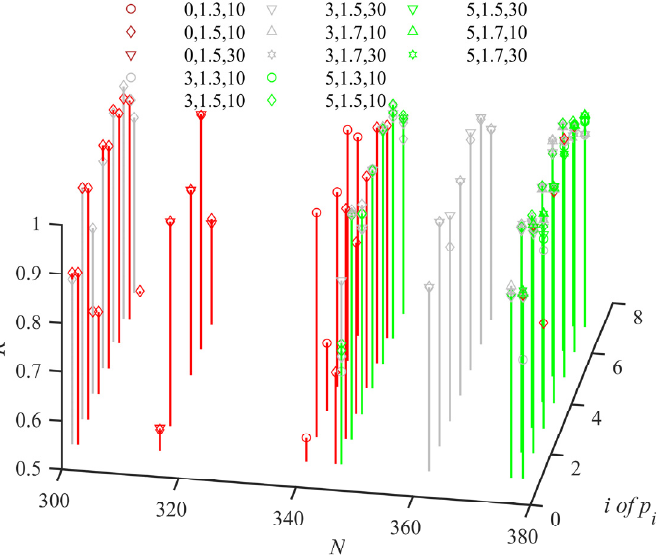
Figure 8. Surrogate models training with different sample points and combination of a p , P min and θ max . Table 2. Selected models for different